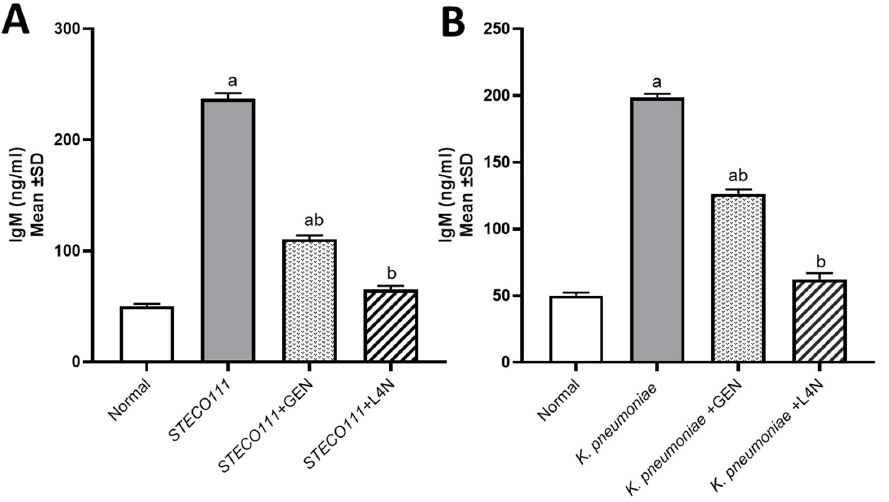
Figure 4. Immunoglobulin M (IgM, ng/mL) levels in the model of mice infected with MDR K. pneumoniae ( A ) and E. coli STEC O111 ( B ) and then treated with luteolin 4 ′‐ neohesperidoside (L4N) and gentamycin (GEN). a Significant difference from normal control group at p < 0.05. b Significant difference from infected group at p < 0.05. ab Significant difference from normal control group and infected group at p < 0.05.